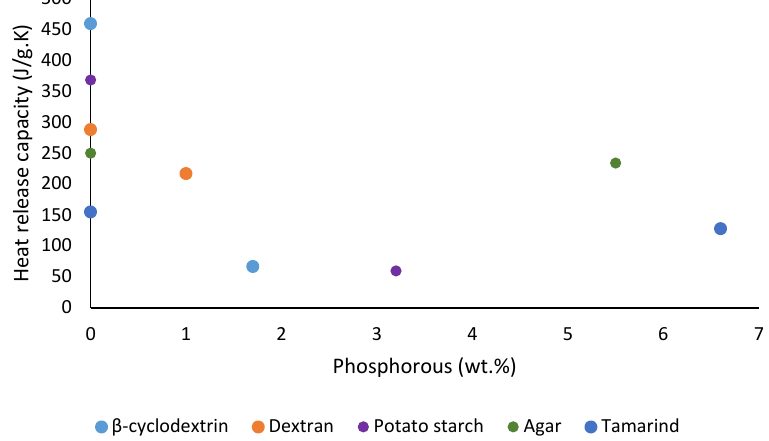
Figure 15. Plot of the heat release capacity versus phosphorus content (wt. %) of the substrates.